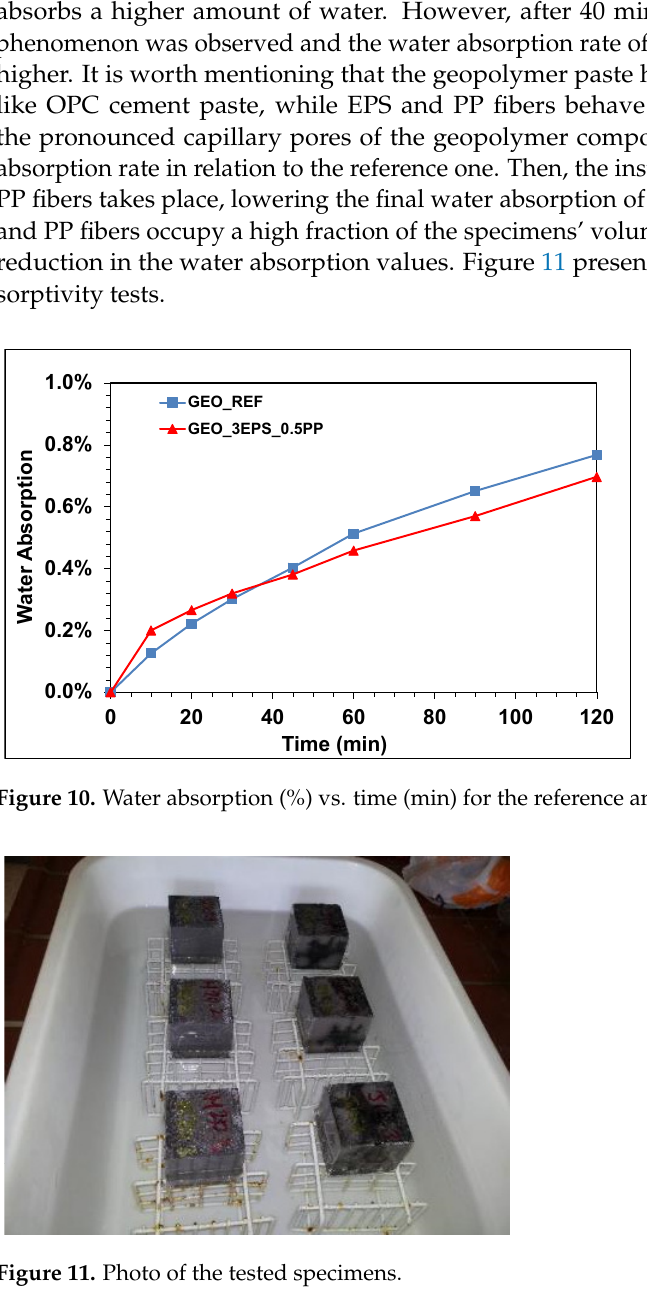
Figure 12. Association between water absorption per unit area and square root of time. Table 6. Sorptivity and R 2 values of tested geopolymers. Samples